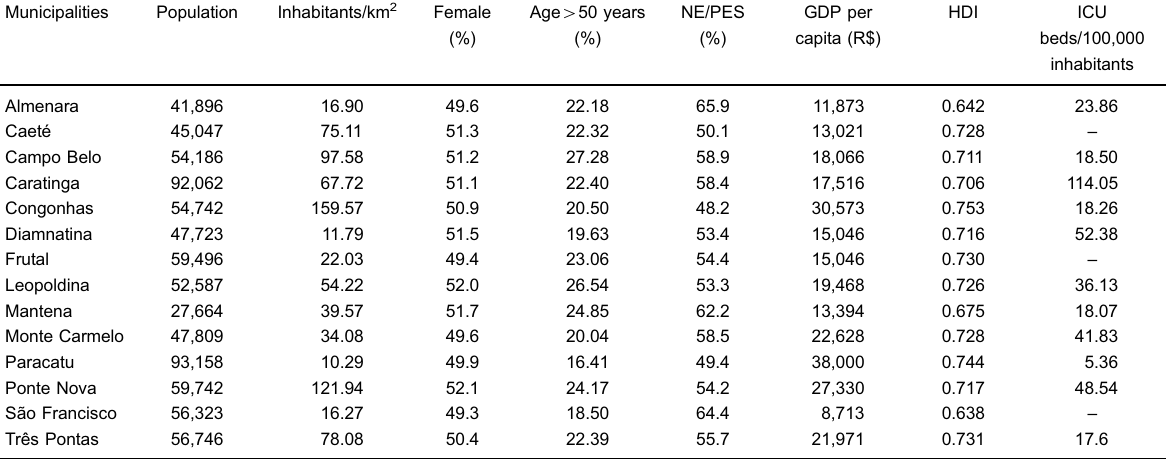
Table 1. Sociodemographic characteristics of municipalities from the 14 health macro-regions of Minas Gerais state.